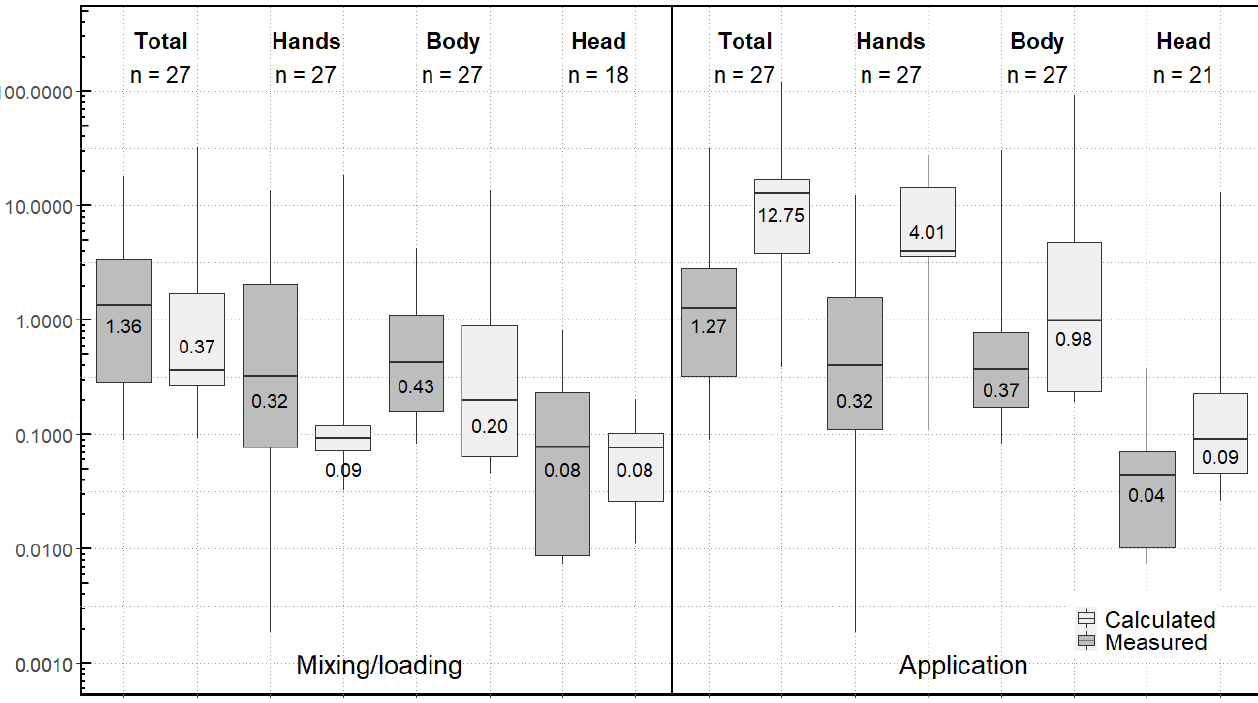
Figure 2. Exposure (mg/day) during mixing/loading and during application, overall (total: hands + body + head) and according to body parts, calculated using the AOEM and measured in the CANEPA study.